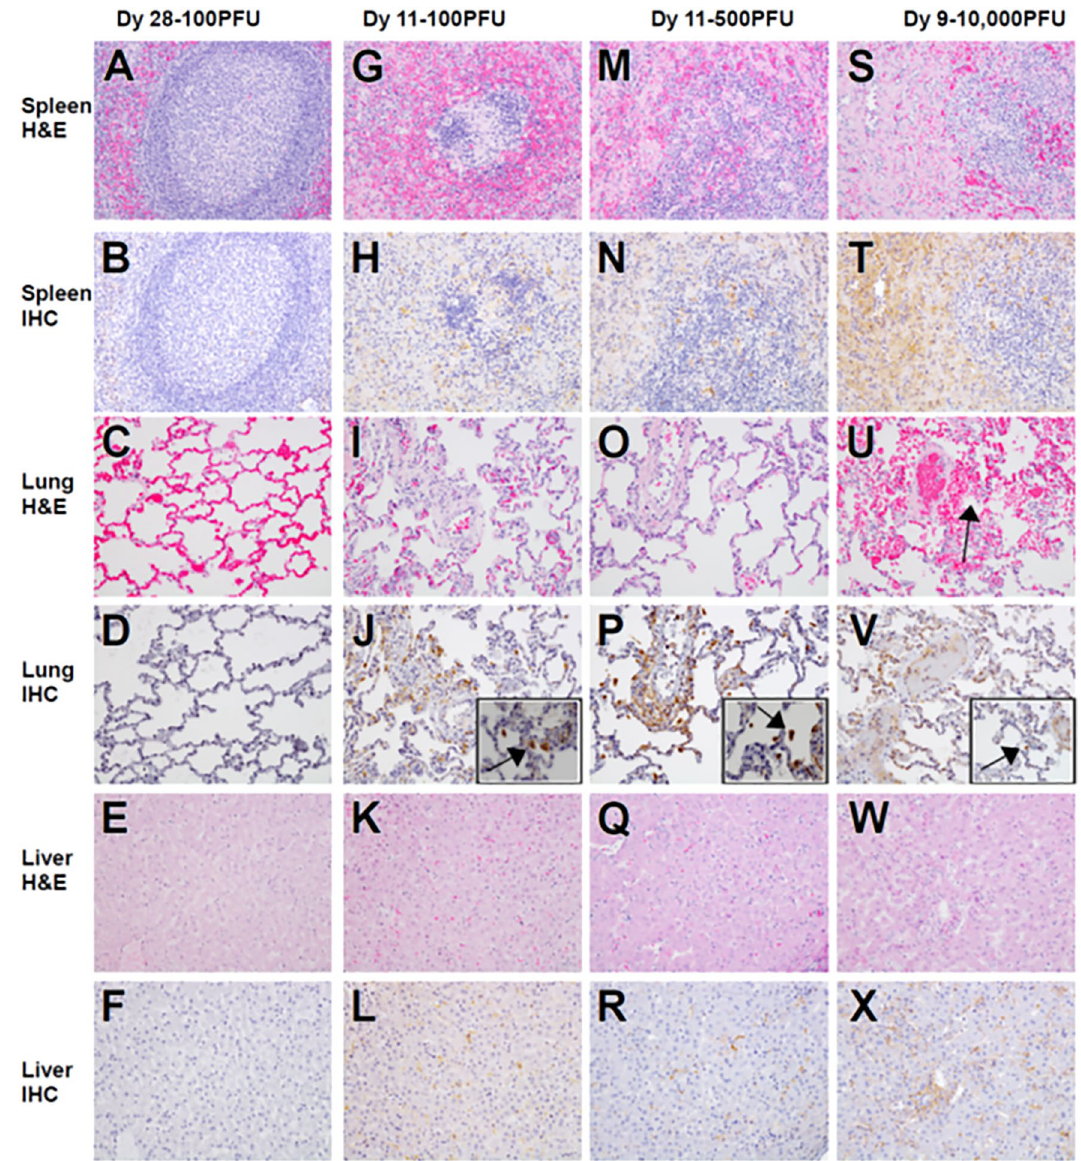
Figure 3. Representative histologic lesions in cynomolgus macaques infected with EBOV Makona variant via conjunctival route. Representative tissues of cynomolgus macaques from 100 PFU, survivor (100-6) ( A – F ) and succumbed 11 dpi (100-4) ( G – L ), 500 PFU, succumbed 11 dpi (500-4) (M-R) and 10,000 PFU, succumbed 9 dpi (10K-6) ( S – X ). All images captured at 20x, insets captured at 40x. Hematoxylin and eosin (H&E) staining ( A , G , M , S , C , I , O , U , E , K , Q , W ) and immunohistochemistry (IHC) for anti-EBOV antigen ( B , H , N , T , D , J , J ,Inset, P , P inset, V , V inset, F , L , R , X ). No significant lesions (NSL) and no significant immunolabeling (NSI) for spleen ( A , B ), lung ( C , D ) and liver ( E , F ) of 100 PFU survivor. Splenitis with lymphoid depletion and fibrin deposition in NHPs that succumb at 100 PFU ( G ), 500 PFU ( M ) and 10,000 PFU ( S ). Diffuse cytoplasmic immunolabeling of mononuclear cells (brown) in red and white pulp of the spleen in those that succumb ( H , N , T ). Diffuse interstitial pneumonia ( I , O , U ) with alveolar hemorrhage ( U , black arrow). Diffuse cytoplasmic immunolabeling (brown) of mononuclear cells within the lung ( J , P , V ) and alveolar spaces (insets J , P , V , black arrows). Necrotizing hepatitis ( K , Q , W ). Diffuse cytoplasmic immunolabeling (brown) of Kupffer cells, sinusoidal lining cells and rarely hepatocytes ( L , R , X all other examined organs of this macaque (Fig. 3A–F). No prominent lesions or IHC labeling for anti-EBOV antigen were detected in examined tissues of 4/6 macaques from the 100 PFU cohort (100-1,100-2,100-3, 100-5) and 5/6 macaques from 500 PFU cohort (500-1, 500-2, 500-3, 100-5, 500-6) (data not shown). Enzyme-linked immunosorbent assay (ELISA) detection of anti-EBOV antibodies. Terminal sera from all animals surviving to the study endpoint (28 dpi) was analyzed by ELISA and PRNT 50 for the